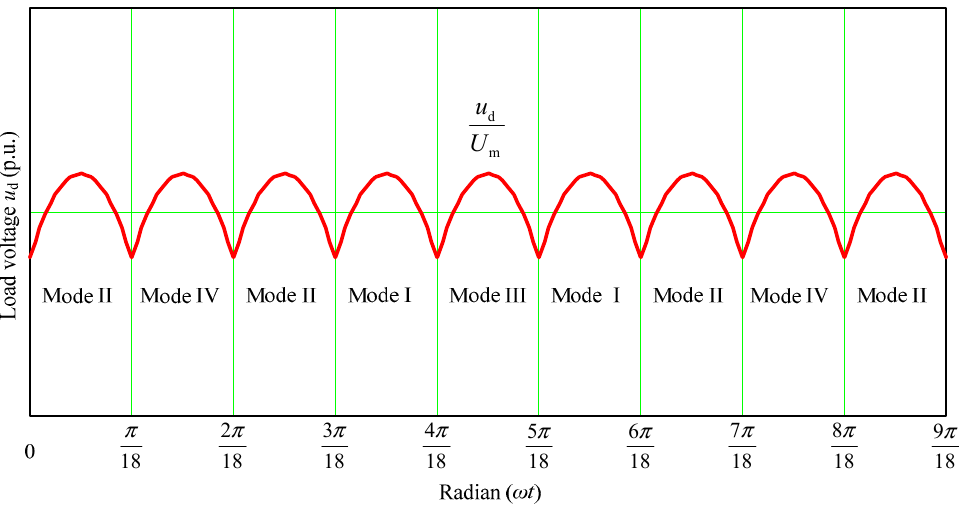
Figure 8. Theoretical waveform of load voltage under the optimal parameters.